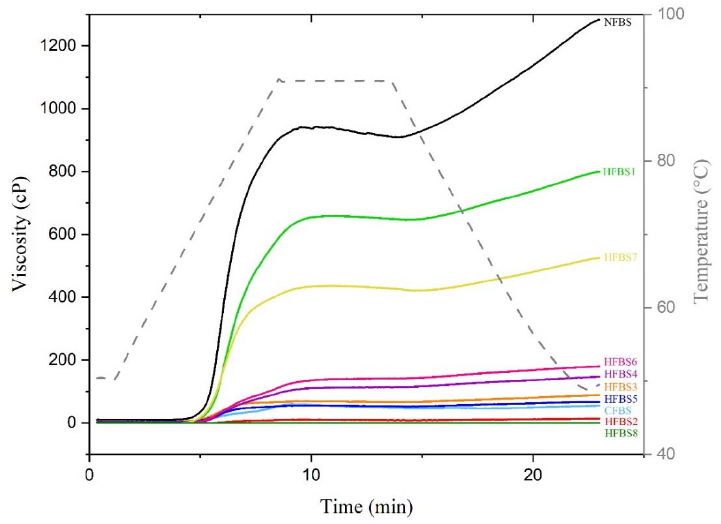
Figure 2. Brabender viscosity curves of native and hydrolyzed faba bean starches. NFBS, native faba bean starch; CFBS, conventional hydrolysis faba bean starch; HFBS1, HFBS2, HFBS3, HFBS4, HFBS5, HFBS6, HFBS7, and HFBS8, hydrolyzed faba bean starches.